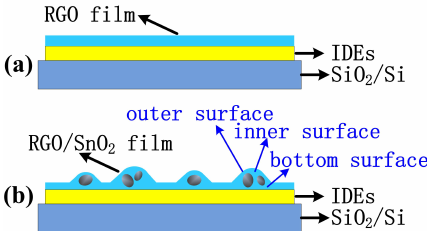
Figure 6. Schematic diagrams of ( a ) RGO film ( b ) RGO/SnO 2 composite